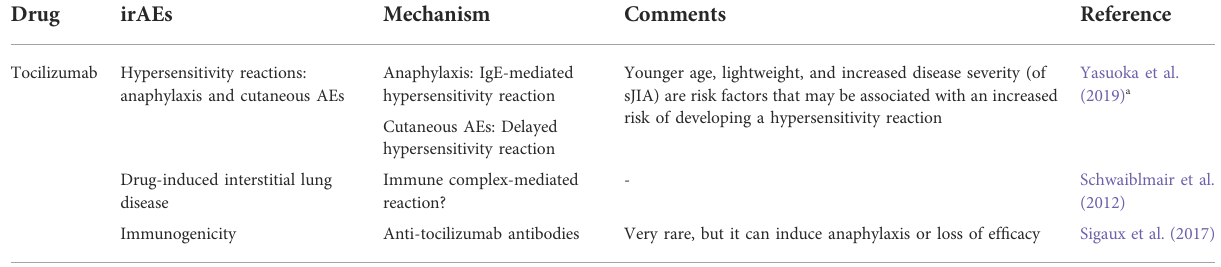
TABLE 1 Mechanisms of irAEs with the use of tocilizumab. Drug